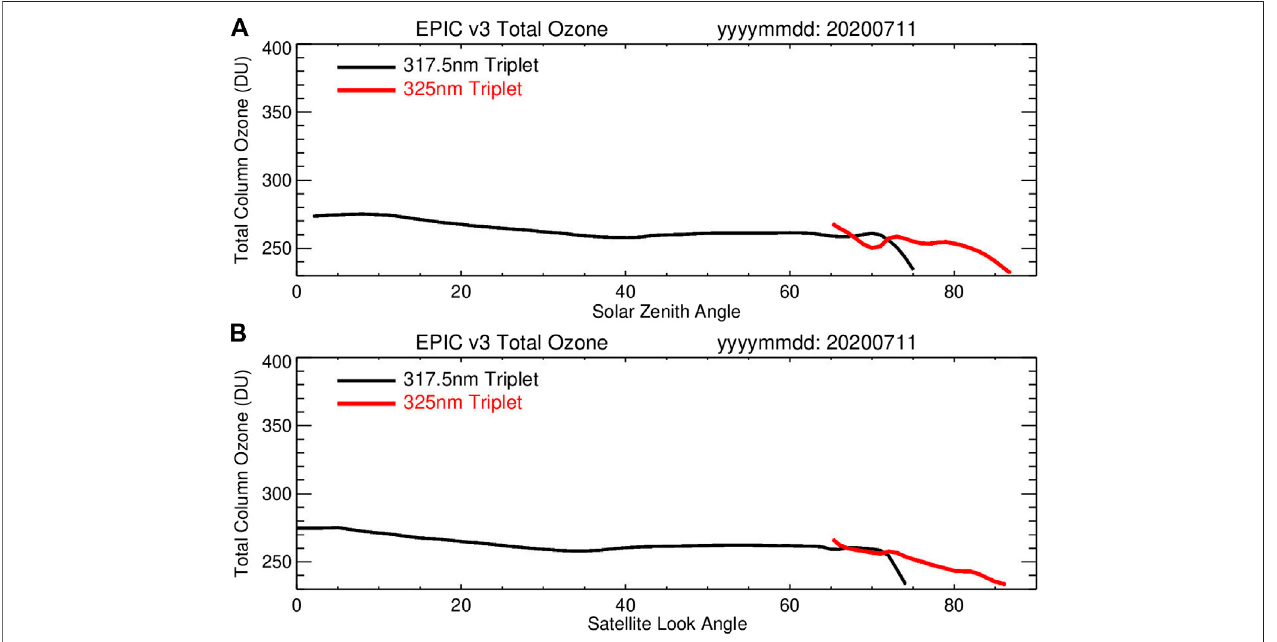
FIGURE 3 | EPIC version-3 total column observations (in DU) on July 11, 2020 averaged for an entire day over a wide equatorial zone (20 ° S-20 ° N) as a function of SZA (A) and SLA (B) . EPIC retrievals with 317.5 nm triplet are shown in black and 325 nm triplet in red. In this study, we use EPIC total ozone retrievals from 317.5 nm triplet only (algorithm fl ag equal 1, or 101, or 111) and limit SZA and SLA to less than 70 ° .